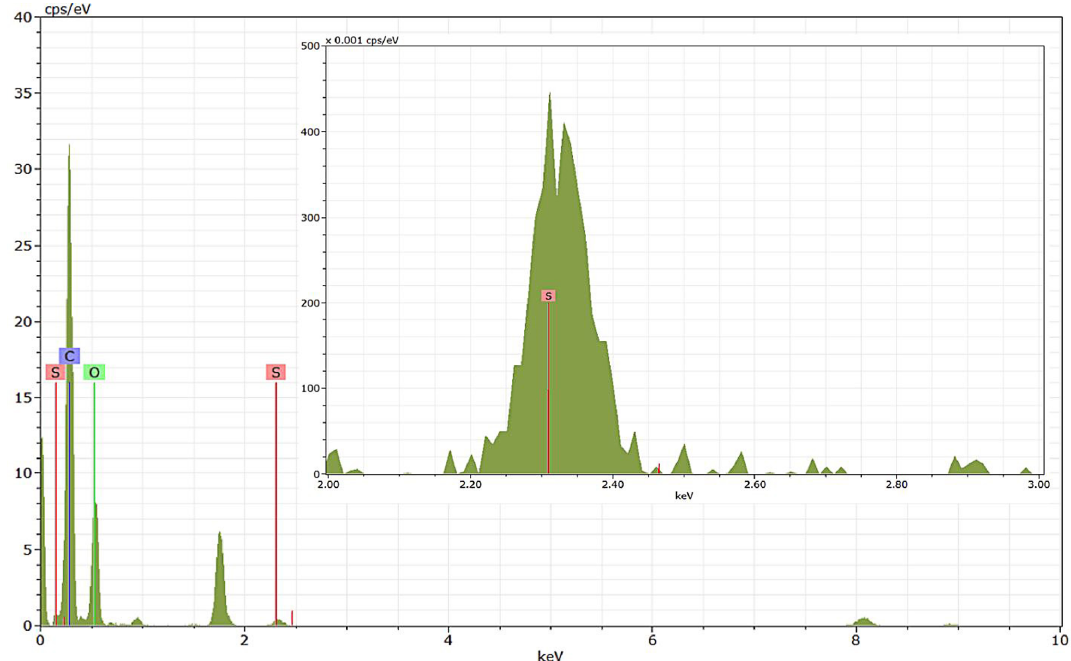
Figure C10. EDX spectra for AOI of thinly coated FW200 soot (H 2 SO 4 coating wt = 2.3%) presented in Fig. 11. The x axis stands for the electron energy (keV) and the y axis represents counts per second per eV (cpseV − 1 ). The position of carbon (C), oxygen (O) and sulfur (S) is indicated in the figure. The zoom-in patch shows the sulfur region of the spectra, which is not legible in the main spectrum.